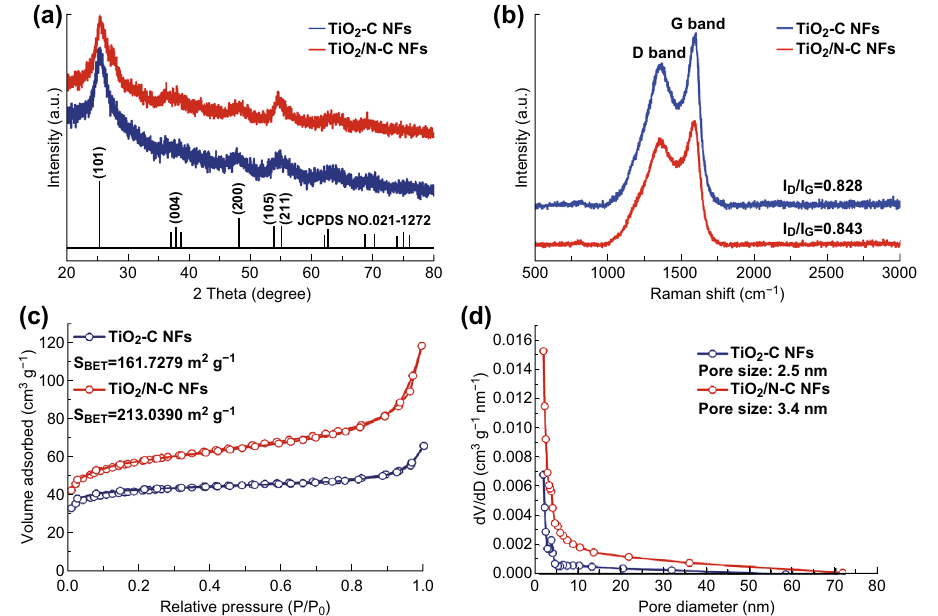
Fig. 1 a XRD patterns and b Raman spectra of TiO 2 /N–C NFs and TiO 2 –C NFs. c N 2 adsorption–desorption isotherms and d the corresponding pore size distributions of TiO 2 /N–C NFs and TiO 2 –C